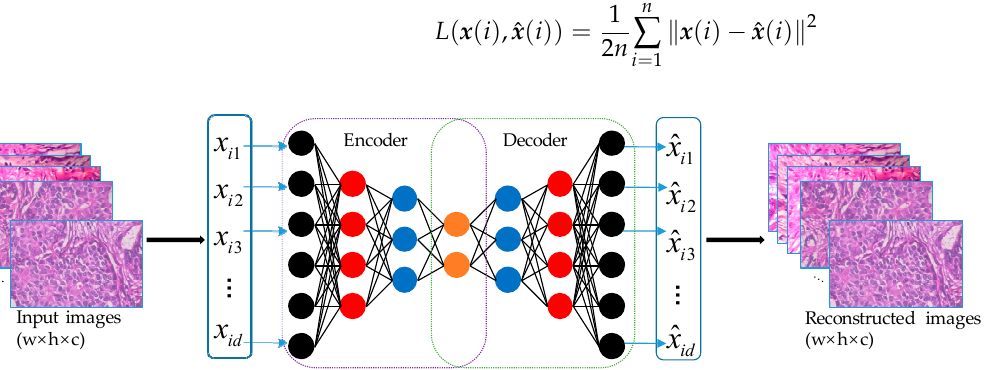
Figure 1. The architecture of Autoencoder. Autoencoder learns the effective features of data by minimizing the error between the input data and the reconstructed data.